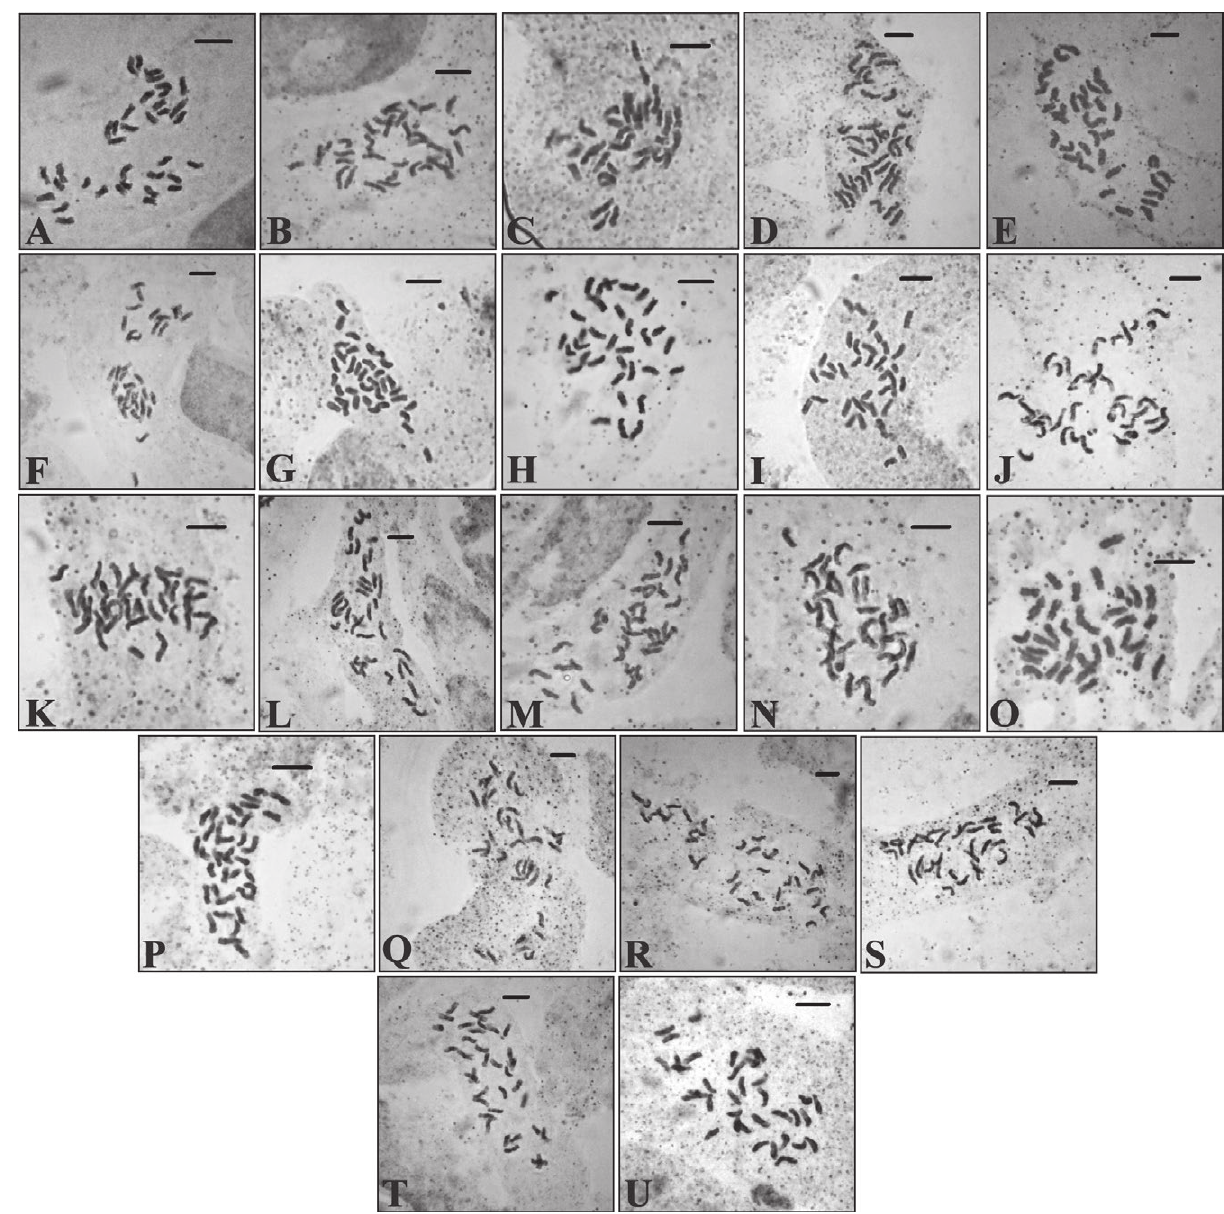
Figure 2. Somatic metaphase chromosomes of Chenopodium quinoa (2n=36): (A) BL71 (B) BL72 (C) BL–D75 (D) BL–X3 (E) RD14 (F) RD31 (G) RD36 (H) RD47 (I) RD56 (J) RD58 (K) RD8 (L) RD–D88 (M) RD–X2 (N) WH32 (O) WH82 (P) WH–X1 (Q) YEL59 (R) YEL61 (S) YEL63 (T) YEL71 (U) YEL–X4 (bar= 5